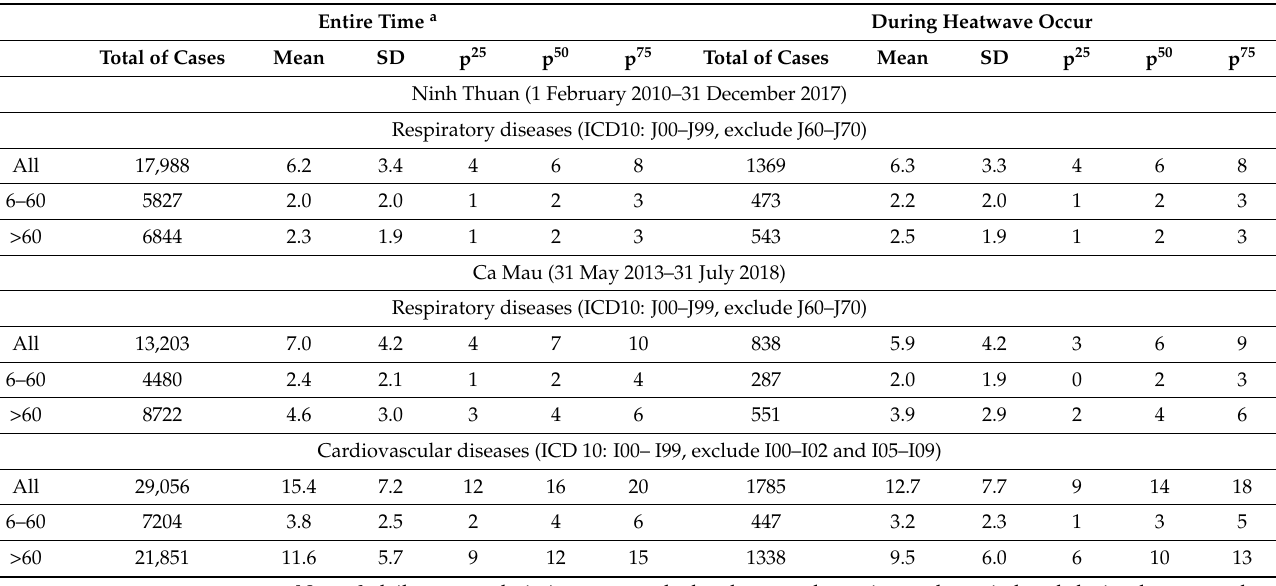
Table 1. Hospital admission for respiratory and cardiovascular diseases in Ninh Thuan and Ca Mau in total and by age group in whole studied periods and periods during heatwaves